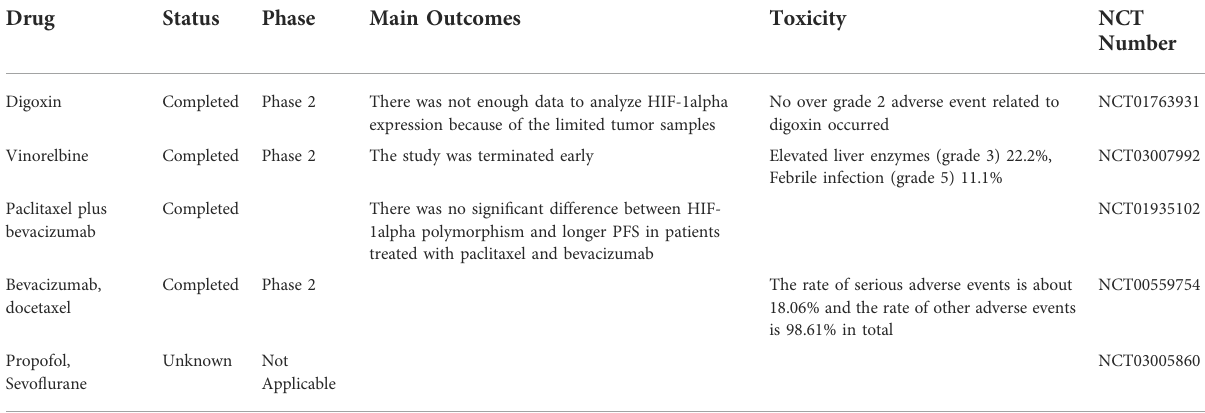
TABLE 1 HIF-1 α related clinical studies in